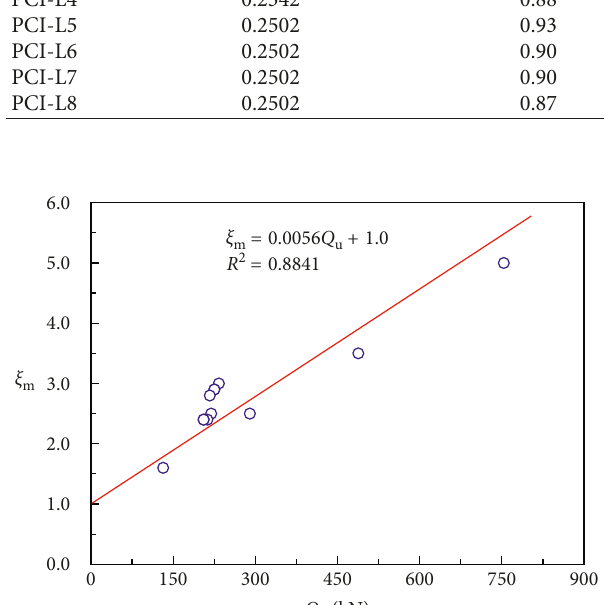
Figure 8: Correlation between the modified coefficient and compressive bearing capacity of improved soil surrounds.